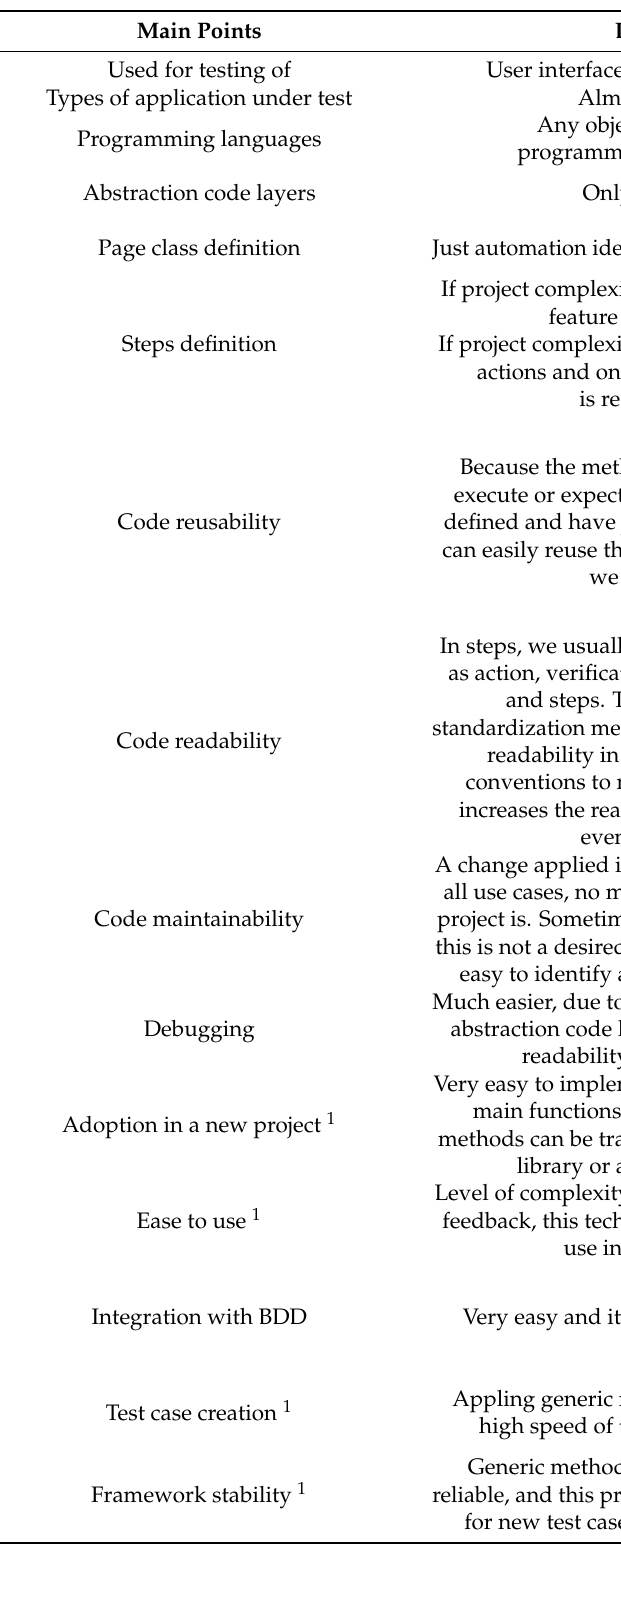
Table 3. Result of using LEE in comparison with